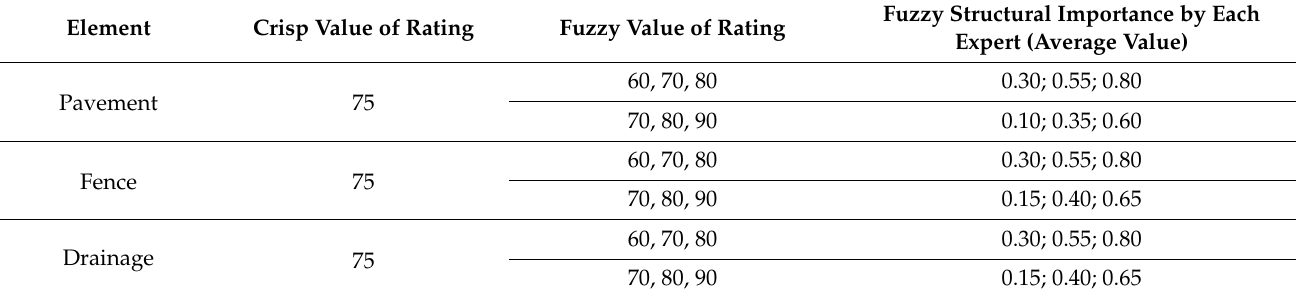
Table 12. Crisp and fuzzy values of ratings of the equipment component elements.